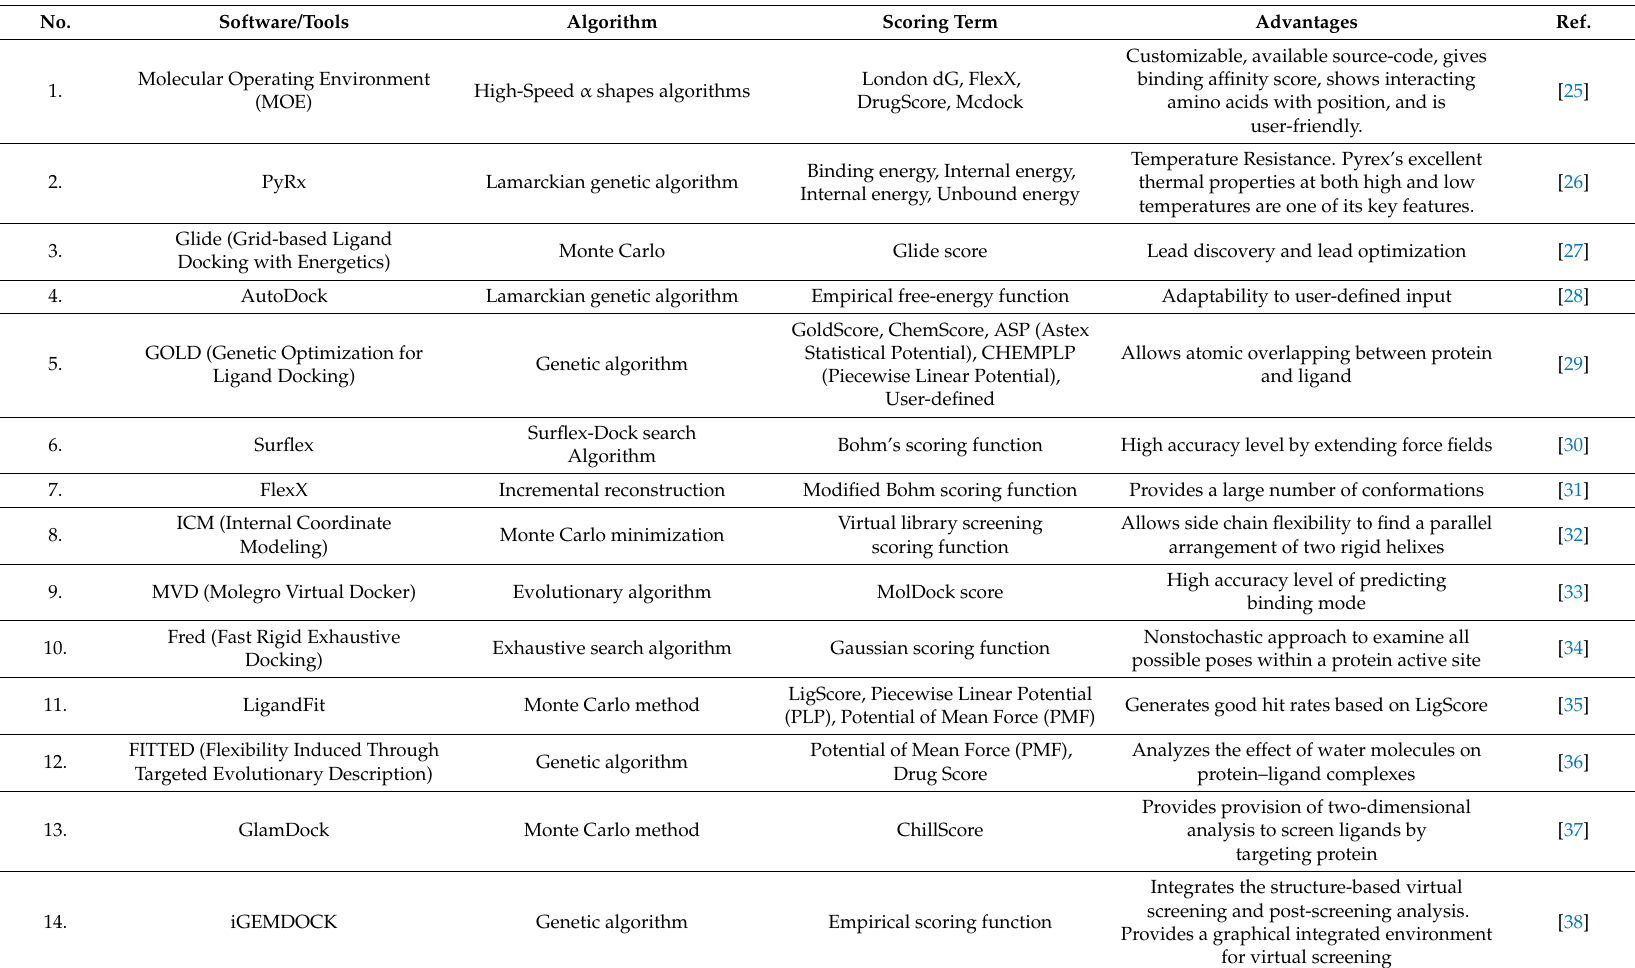
Table 1. A list of widely used tools for